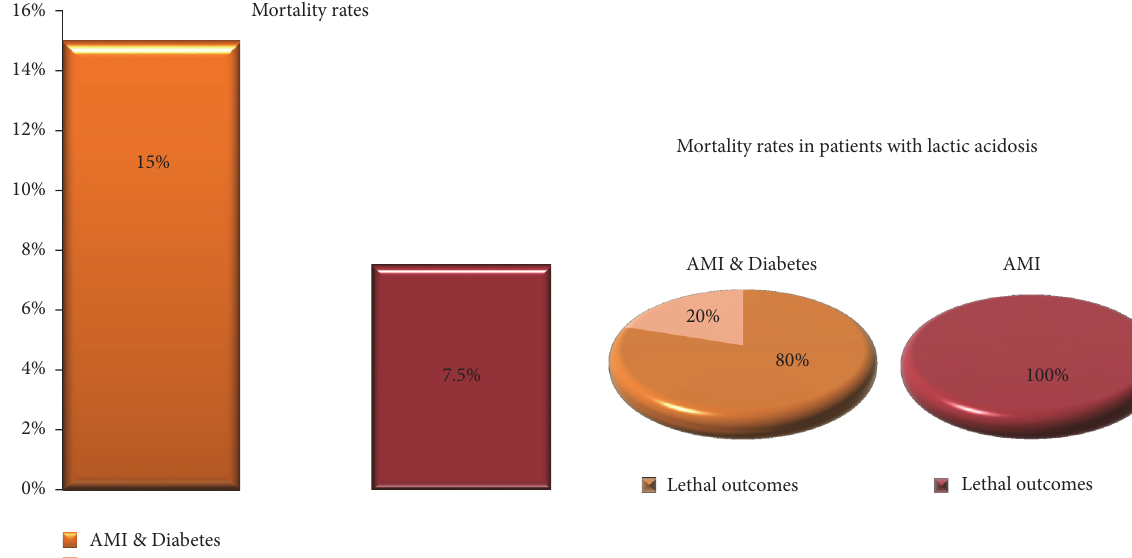
Figure 3: In-hospital mortality rateamong the patientswith acutemyocardial infarctionand diabetes mellitus(AMI & Diabetes) and patients with acute myocardial infarction and normal glucose metabolism (AMI) and prevalence of lethal outcomes among the patients with lactic acidosis in AMI & Diabetes and AMI